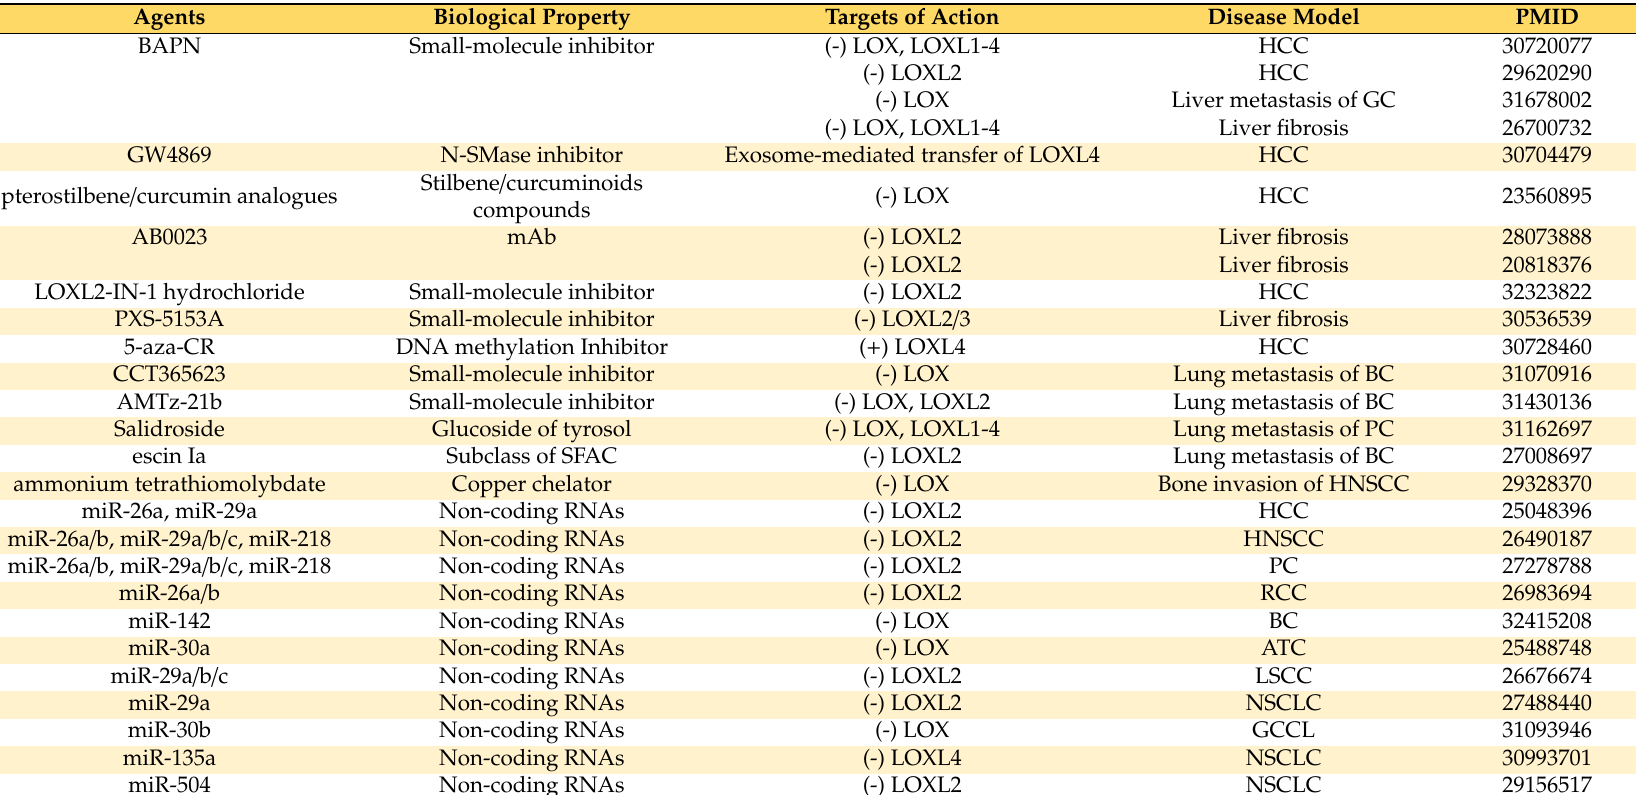
Table 5. Inhibitors targeting LOX family members in preclinical